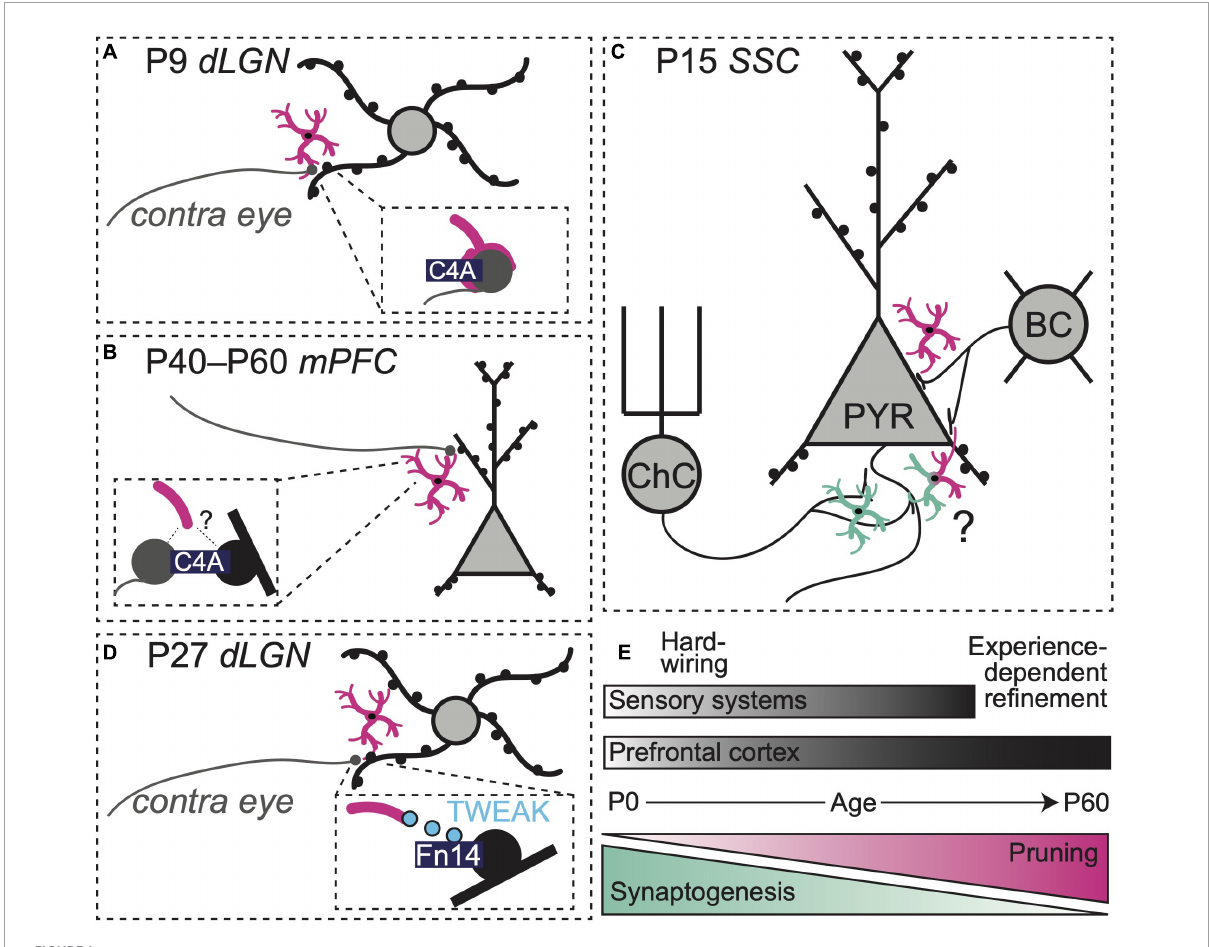
FIGURE1 Region-, synapse-, and age-specific roles for microglia in synapse refinement. (A) Microglia prune retinogeniculate synapses at P9 using a C4-dependent pathway (Yilmaz et al., 2021). (B) Overexpression of C4 enhances synapse pruning in mPFC (Yilmaz et al., 2021). (C) At P15, microglia prune axosomatic synapses between basket cells and pyramidal cells (Favuzzi et al., 2021) while promoting the formation of axo-axonic synapses between chandelier cells and pyramidal cells (Gallo et al., 2022) in rodent somatosensory cortex. (D) Neuronal Fn14 together with microglial TWEAK refine dLGN dendritic spines through activity-dependent, non-phagocytic mechanisms (Cheadle et al., 2020). (E) Synaptogenesis and refinement overlap in space and time and occur over distinct windows of development in sensory systems vs. prefrontal